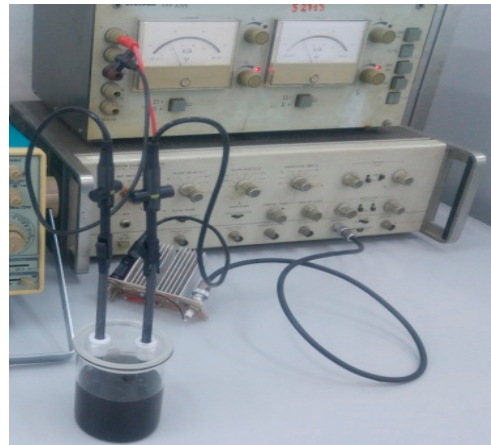
Figure 1. Experimental set-up employed for graphite electrochemical exfoliation by pulses of current (0.5 A intensity; 2.5 s pulse duration; 0.8 s pause between two pulses). (0.5 A intensity; 2.5 s pulse duration; 0.8 s pause between two